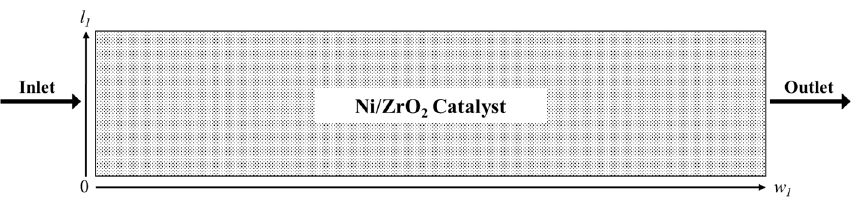
Figure 7. Schematic representation of the packed bed reactor used for the CFD modelling simula-